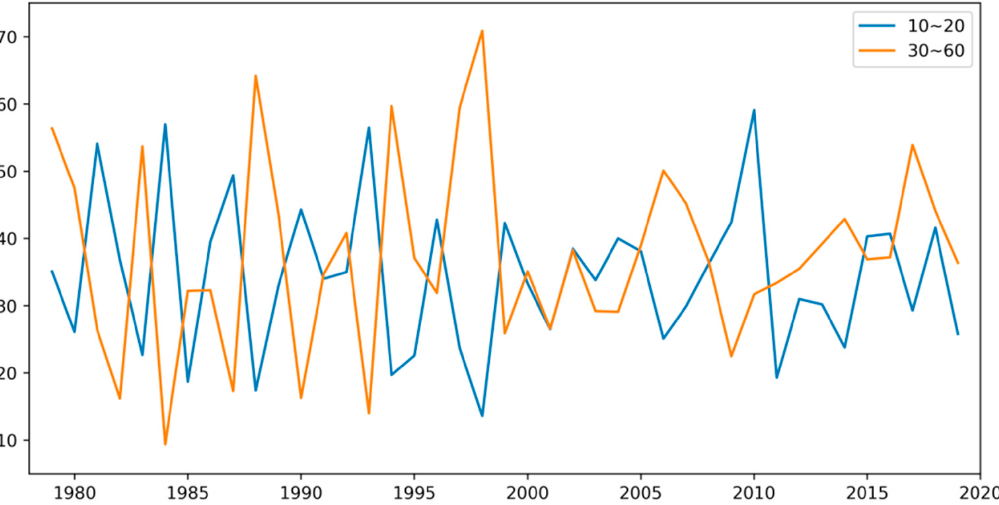
Figure 4. Explained variances of 10–20 days and 30–60 days ISO of EASM in 1979–2019 (the abscissa is explained variance (%) and the ordinate is year).